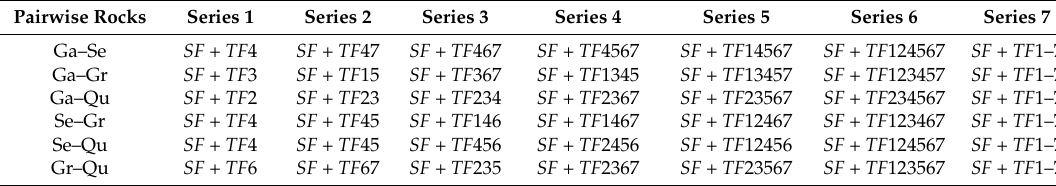
Table 3. Statistically significant J–M distance for the same number of vectors a .